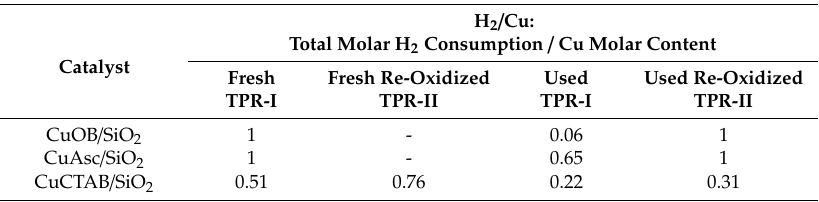
Figure 5. Temperature programmed reduction (TPR) profiles of the calcined fresh catalysts. Calcination treatment: 500 ◦ C in air flow, heating rate: 10 ◦ C min − 1 . Solid line: CuCTAB / SiO 2 , dash line: CuOB / SiO 2 , dash dot line: CuAsc / SiO 2 .